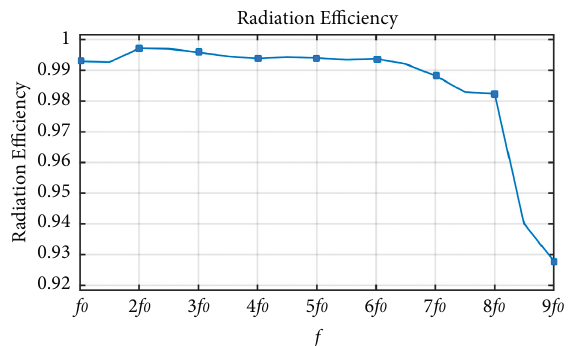
Figure 13: Frequency response of the radiation efficiency of the proposed